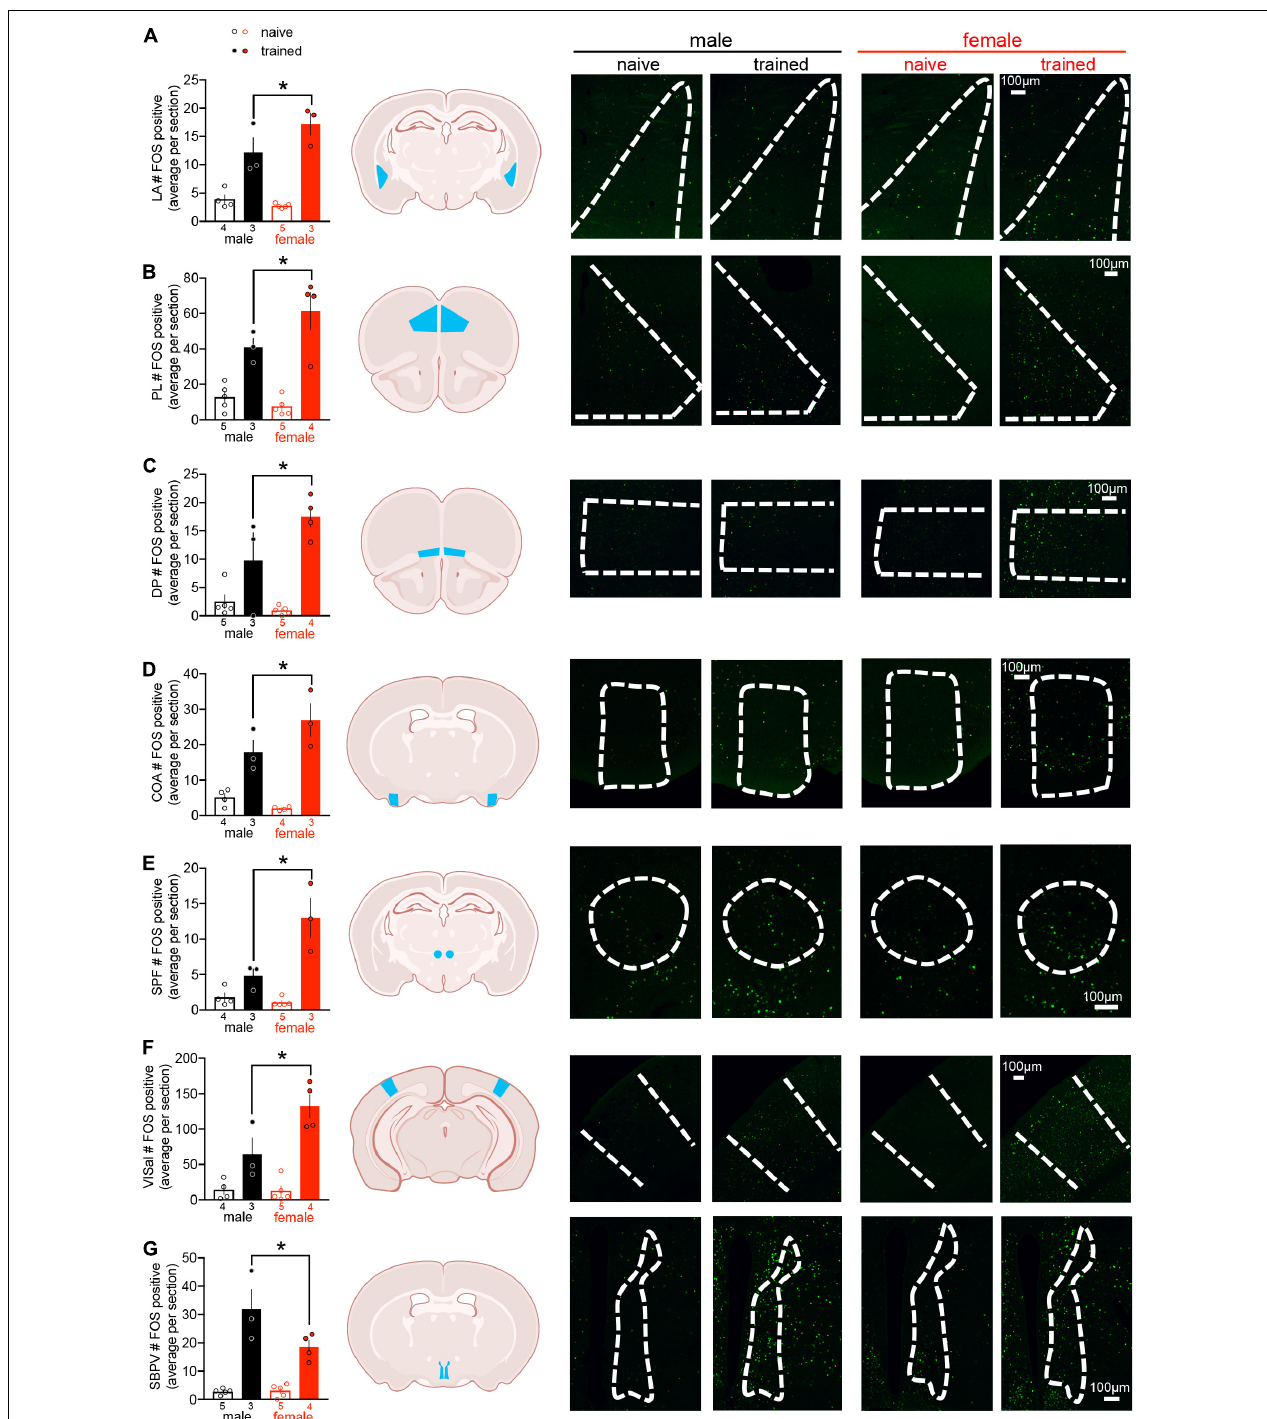
FIGURE 2 | Cued threat conditioning induces limited sex differences in regional c-fos expression. Quantification of regional c-fos expression revealed sex differences in trained males compared to trained females in 7/112 regions: (A) lateral amygdala (LA), (B) prelimbic cortex (PL), (C) dorsal peduncular cortex (DP), (D) cortical amygdalar area (COA), (E) subparafascicular nucleus (SPF), (F) anterolateral visual area (VISal), and (G) subparaventricular zone (SBPV). Data presented as mean ± SEM are on the left. Schemas with each region denoted in blue are in the middle (made with Biorender.com). Representative confocal images with regions outlined in white dashes are on the right. The scale bar on the far right confocal image represents all images for a given brain region. For all regions, two-way ANOVA revealed a main effect of training ( p < 0.05) and an interaction between training and sex ( p < 0.05). Planned post hoc comparisons between trained males and females were conducted with Fisher’s LSD, * p < 0.05. For statistical details, see Supplementary Table 2 . n/group denoted under bar histograms.